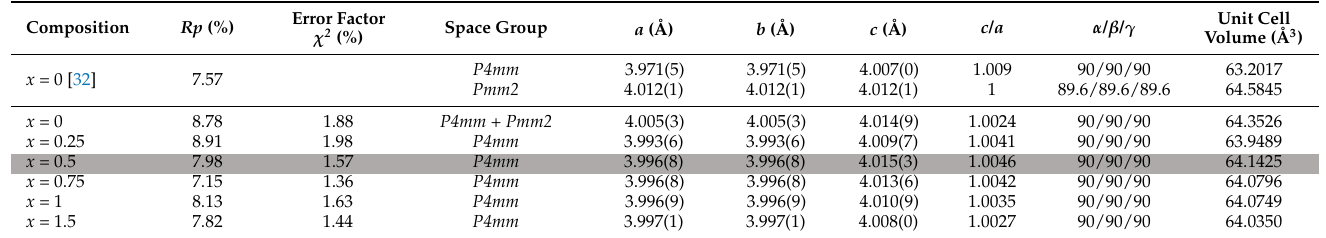
Table 1. Structure parameters of BCZT- x mol%Sm obtained by Rietveld refinement.